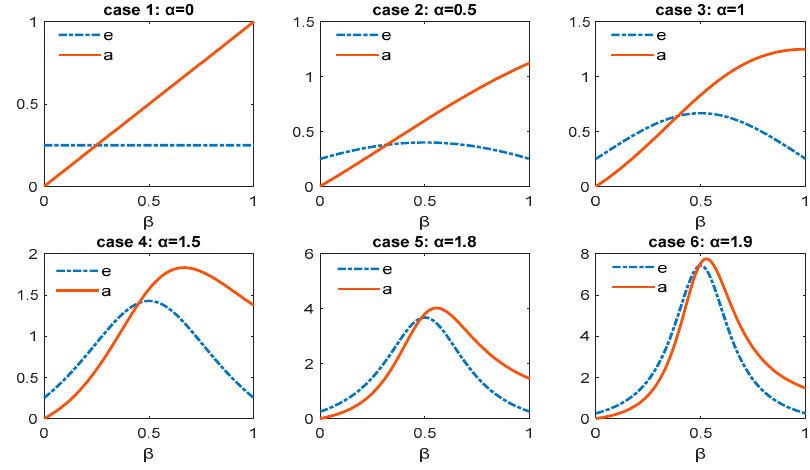
ff orts dynamics for di ff erent complementarity levels α Figure 2. Efforts dynamics for different complementarity levels α . Figure 2. E